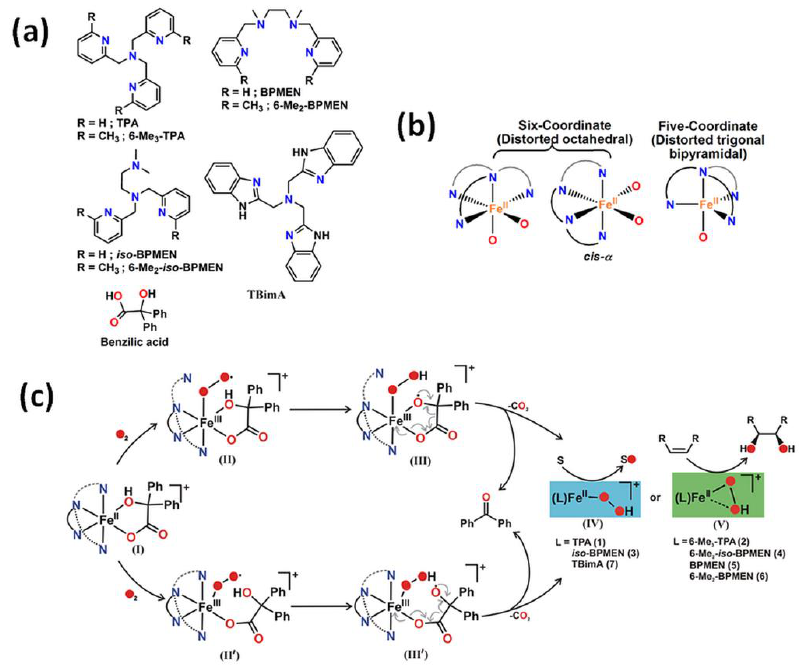
Figure 1. ( a ) Various types of tetradentate ligand; ( b ) coordination geometry at the metal center of iron(II) benzilate complexes; ( c ) The mechanism of oxidative decarboxylation of iron(II) benzilate complexes of tridentate ligands as follows: formation of iron(III) superoxide radical intermediate (II) and analogous iron(III) superoxide radical intermediate (II′), followed by generation of iron(III) hydroperoxo oxyl radical intermediates (III and III′) due to hydrogen atom abstraction from the hydroxy group of α -hydroxy acid. Decarboxylation of III and III′ generates iron(II) hydroperoxo intermediates (IV and V) that could oxidize sulfide to sulfoxide and sulfone, and provide cis -diol product in reactions with olefins (only V) [31]. TPA is equivalent to the TPMA abbreviation. Reprinted with permission from American Chemical Society, Copyright